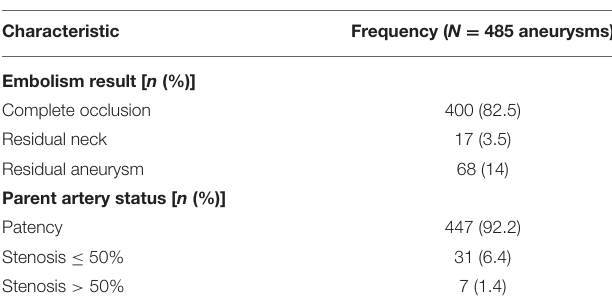
TABLE 4 | Angiographic outcomes.